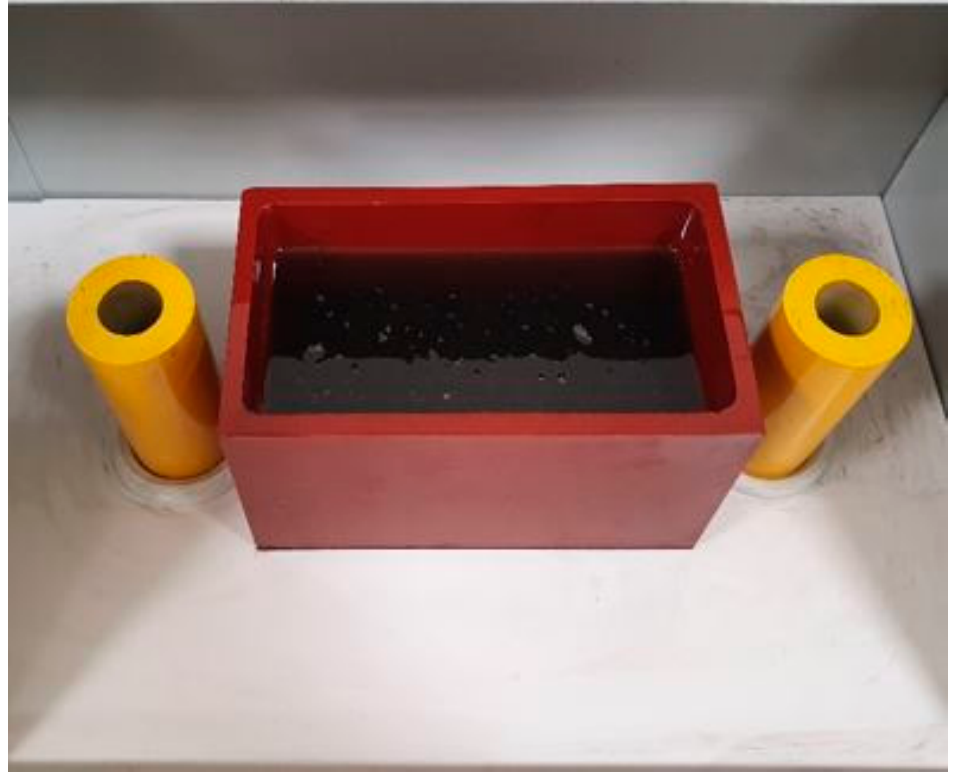
Figure 1. Oil tank with tested liquid.